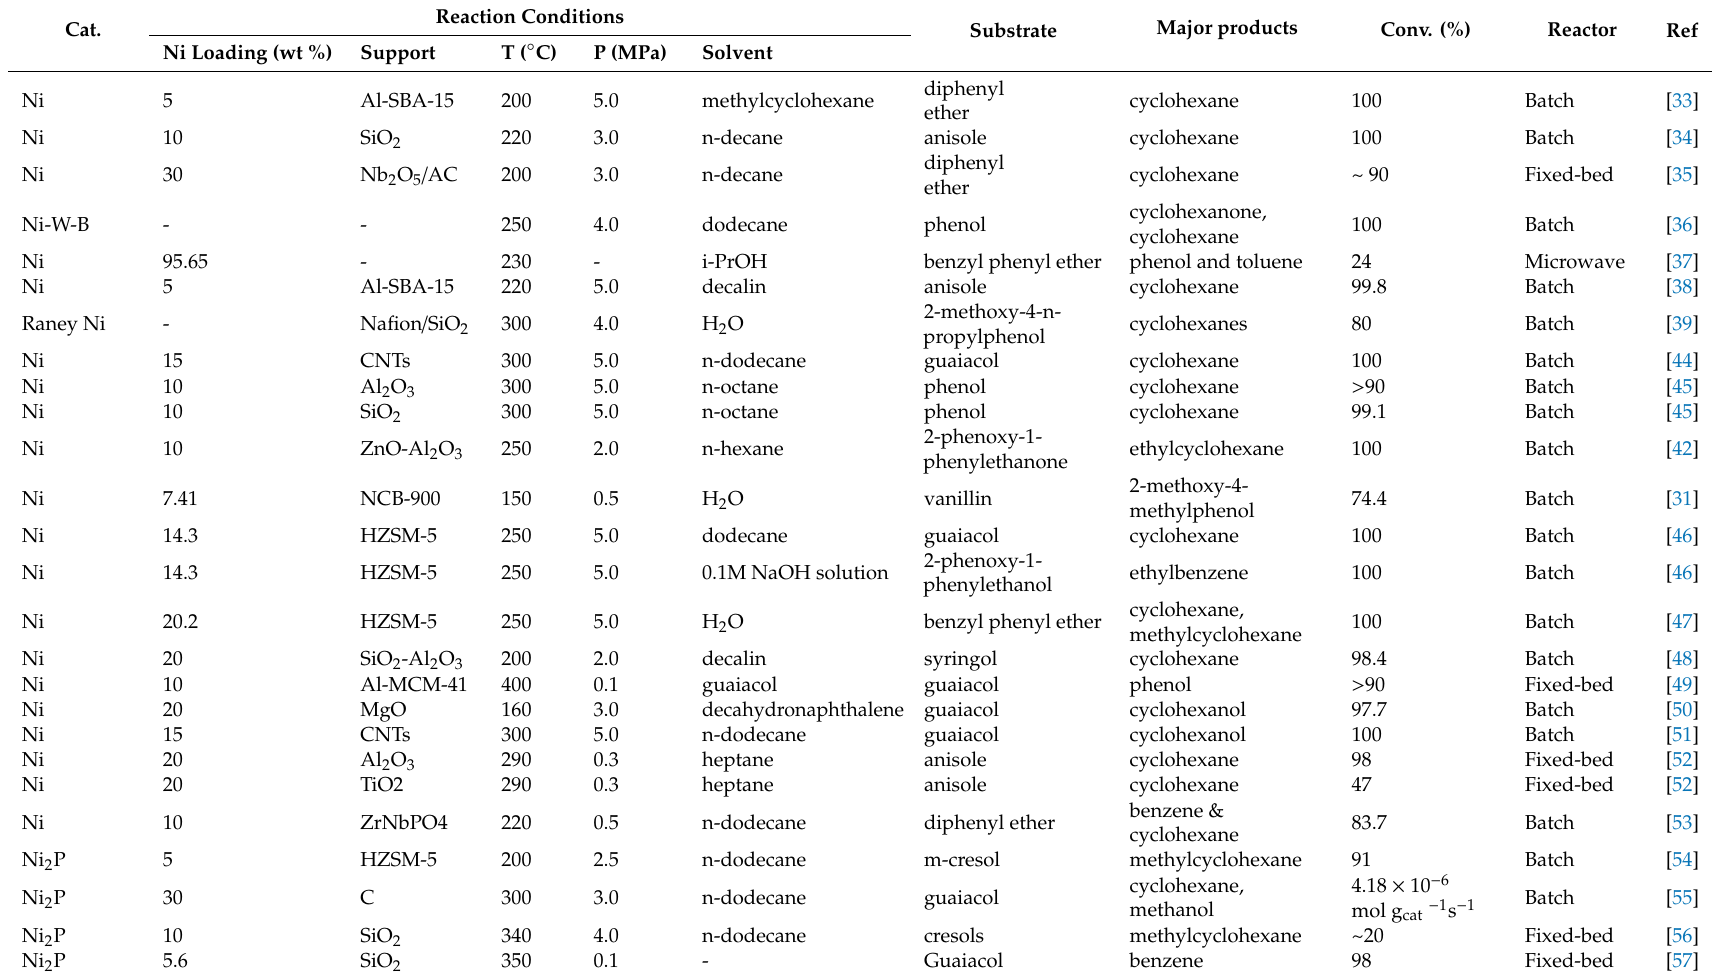
Table 3. Hydrodeoxygenation (HDO) of lignin model compounds over monometallic Ni-based catalysts.